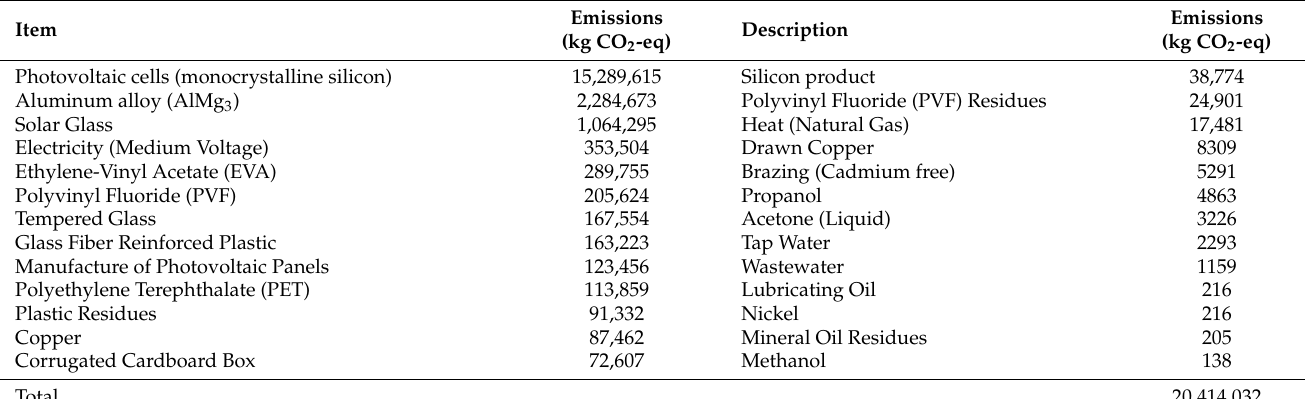
Table 3. GHG emissions for the photovoltaic solar generation